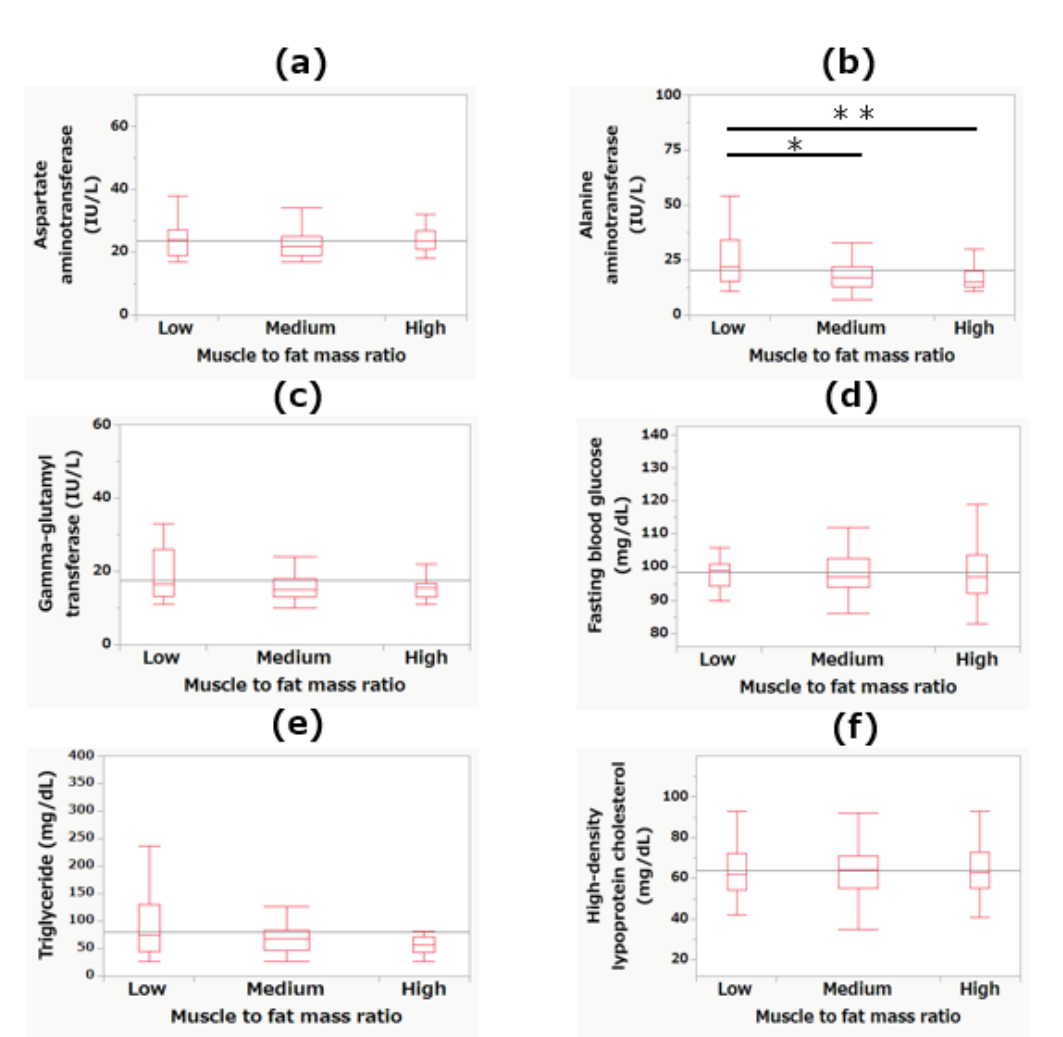
Figure 4. The differences among the tertiles of muscle-to-fat mass ratio in levels of aspartate aminotransferase ( a ), alanine aminotransferase ( b ), gamma-glutamyl transferase ( c ), fasting blood glucose ( d ), triglyceride ( e ), and high-density lipoprotein cholesterol ( f ). * p < 0.05; ** p < 0.01. Table 2. Adjusted odds ratio (95% confidence interval) of decreased muscle-to-fat mass ratio tertiles for serum alanine aminotransferase >26 U/L (screening indicator for